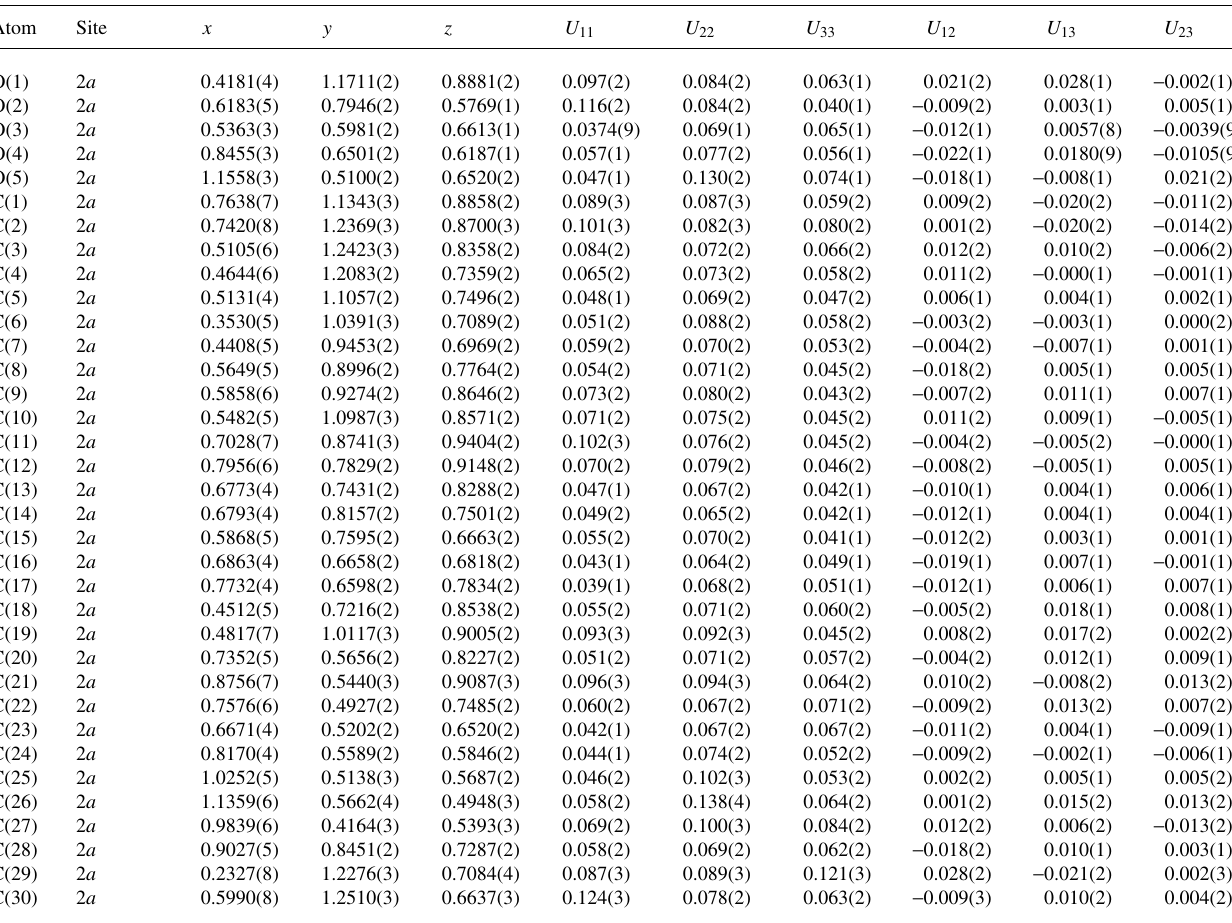
Table 3. Atomic coordinates and displacement parameters (in Å 2 )